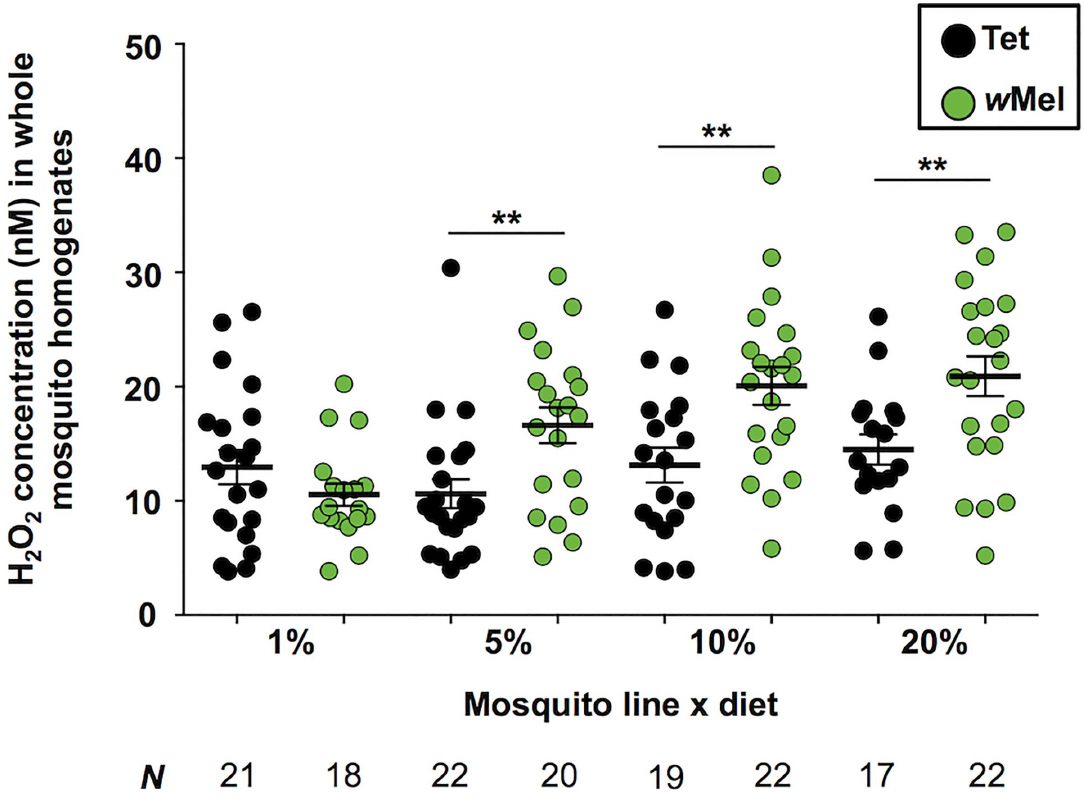
Fig 6. ROS induction in w Mel-infected Ae . aegypti fed on different carbohydrate regimes. Levels of reactive oxygen species (H 2 O 2 ) were quantified for whole w Mel (+ Wolb )and Tet (- Wolb )mosquitoesfrom all 4 diets using the Amplex Red HydrogenPeroxide/PeroxidaseAssay Kit. Each circle representsone pair of either Tet (circles) or w Mel (green circles) mosquitoes, with 17–22samples examinedfor each treatment. Solid black lines represent mean expression( ± s.e.m.). P values: Student’s t tests, ** < 0.01.